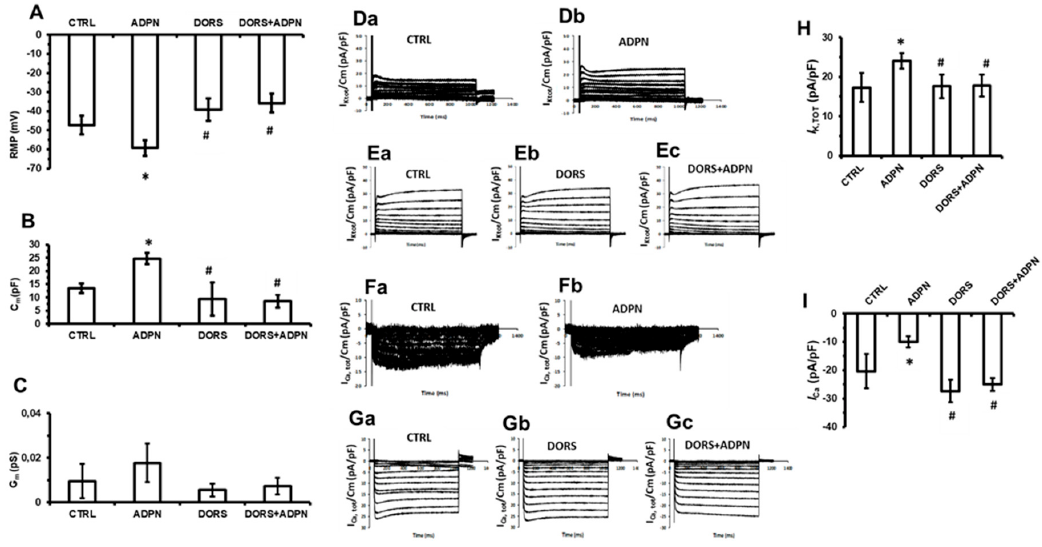
Figure 6. Lack of e ff ects of ADPN on SMC electrophysiological properties and ion currents in the presence of dorsomorphin (DORS). ( A ) Bar charts showing the e ff ect of ADPN and DORS + ADPN on the resting membrane potential (RMP) of the SMCs. ( B ) Bar charts showing the e ff ect of ADPN and DORS + ADPN on the cell capacitance (Cm), the index of cell surface, of the SMCs. ( C ) Bar charts showing the e ff ect of ADPN and DORS + ADPN on the membrane conductance (Gm), the index of membrane permeability, of the SMCs. ( Da , Db ) Typical tracing of total outward K + current recorded in a single control cell ( Da ) and after ADPN addition ( Db ). ( Ea–Ec ) Typical tracing of total outward K + current recorded in a single control cell ( Ea ), in dorsomorphin ( Eb ) and after ADPN addition in the presence of dorsomorphin ( Ec ). ( Fa , Fb ) Typical tracing of total inward Ca 2+ current recorded in a single control cell ( Fa ) and after ADPN addition ( Fb ). ( Ga–Gc ) Typical tracing of total inward Ca 2+ current recorded in a single control cell ( Ga ), in dorsomorphin ( Gb ) and after ADPN addition in the presence of dorsomorphin ( Gc ). All current values are normalized to cell capacitance. ( H ) Bar charts representing the effects of ADPN, DORS, and DORS+ADPN on the total K + current outflow. ( I ) Bar charts representing the effects of ADPN, DORS, and DORS+ADPN on the total calcium current inflow. Bar charts are related to the current amplitude evoked by the +50 mV step pulse, measured at the end of the stimulus for K + current and in the initial part of the stimulus for Ca 2+ currents (Ip, peak current). Data evaluated in control condition (CTRL), 15 min after adiponectin addition to the bath solution (ADPN), and after adding adiponectin in the presence of dorsomorphin. One-way ANOVA with Bonferroni’s post hoc test was used for multiple comparisons. *, p < 0.05 vs. control; #, p < 0.05 vs. ADPN. Current mean values ±SD are listed in Table 1.